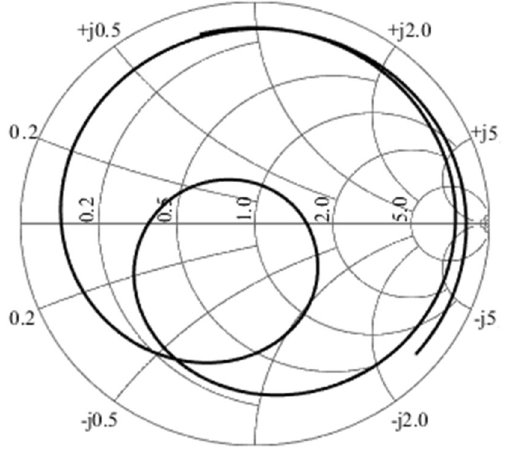
Figure 8. Input impedance at Smith chart for constructed antenna array 2.